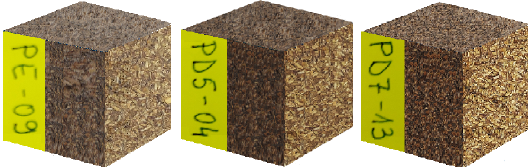
Figure 2. Cubes submitted to compressive